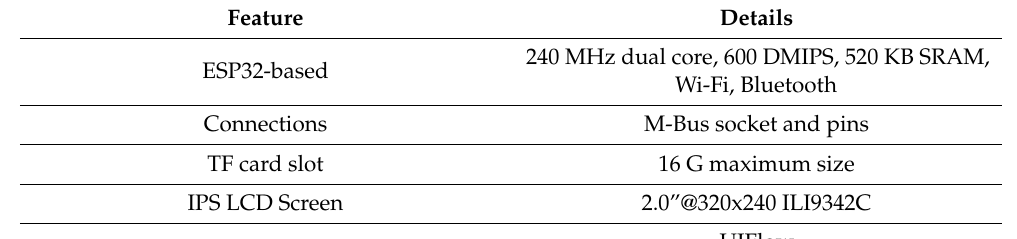
Figure 2. Components of interest of the M5Stack Core2. Table 2. Interesting features of the M5Stack Core2 [35].